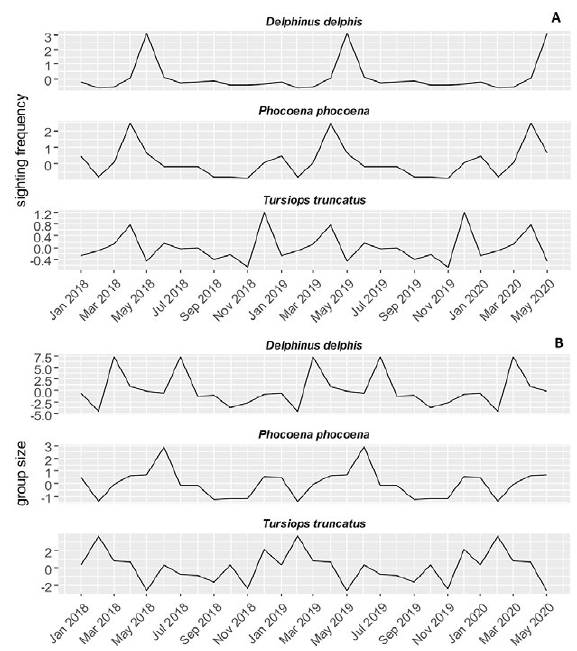
Fig. 6. – The seasonal component of the sighting frequency (A) and the mean group size (B) for the three cetacean species after the